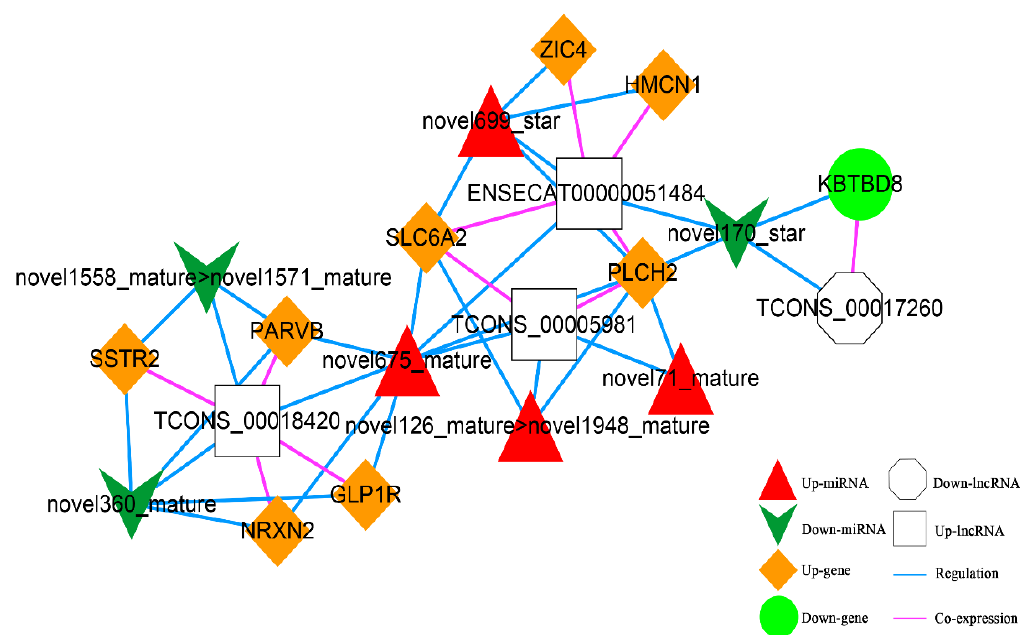
Figure 11. The lncRNA-miRNA-mRNA Network. Orange diamond and green ellipse represent the up-regulated and down-regulated genes, respectively; white rectangle and octagon show the up-regulated and down-regulated lncRNA, respectively; red triangle and green V indicate the up-regulated and down-regulated miRNA, respectively. The pink and blue line represents the co-expression and regulatory relationship, respectively.